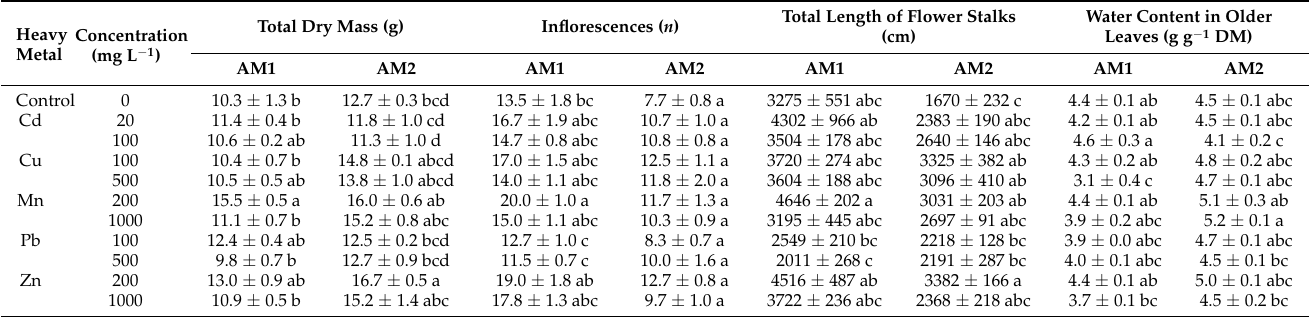
Table 4. Effect of heavy metal treatment on morphological parameters of Armeria maritima accessions AM1 and AM2 cultivated for 9 weeks in soil.